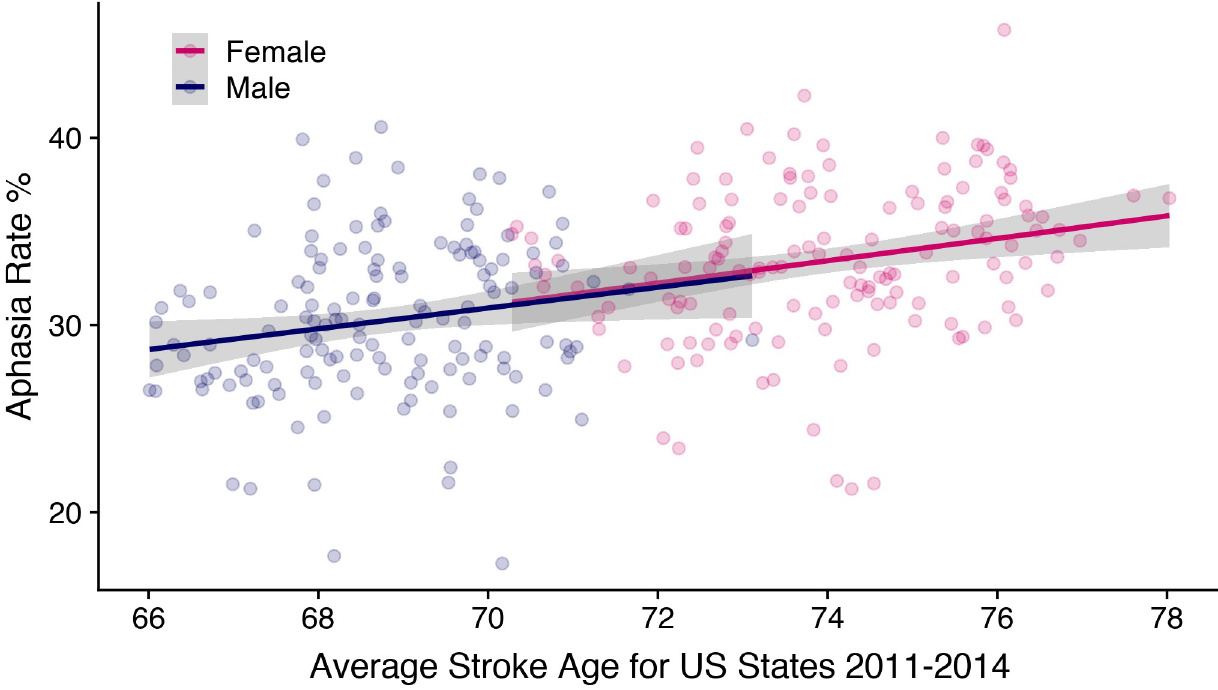
Fig 5. Aphasia rate as a function of age at stroke. A scatterplot of stroke average age against aphasia rate for each US state and year (2011–2014) in the HCUP database. The plot illustrates the large age difference between men and women at time of stroke. It also shows a positive correlation between average age and aphasia rate, suggesting that older stroke patients more often get aphasia. When this relationship is taken into account, sex effects are no longer significant in the aphasia rates.